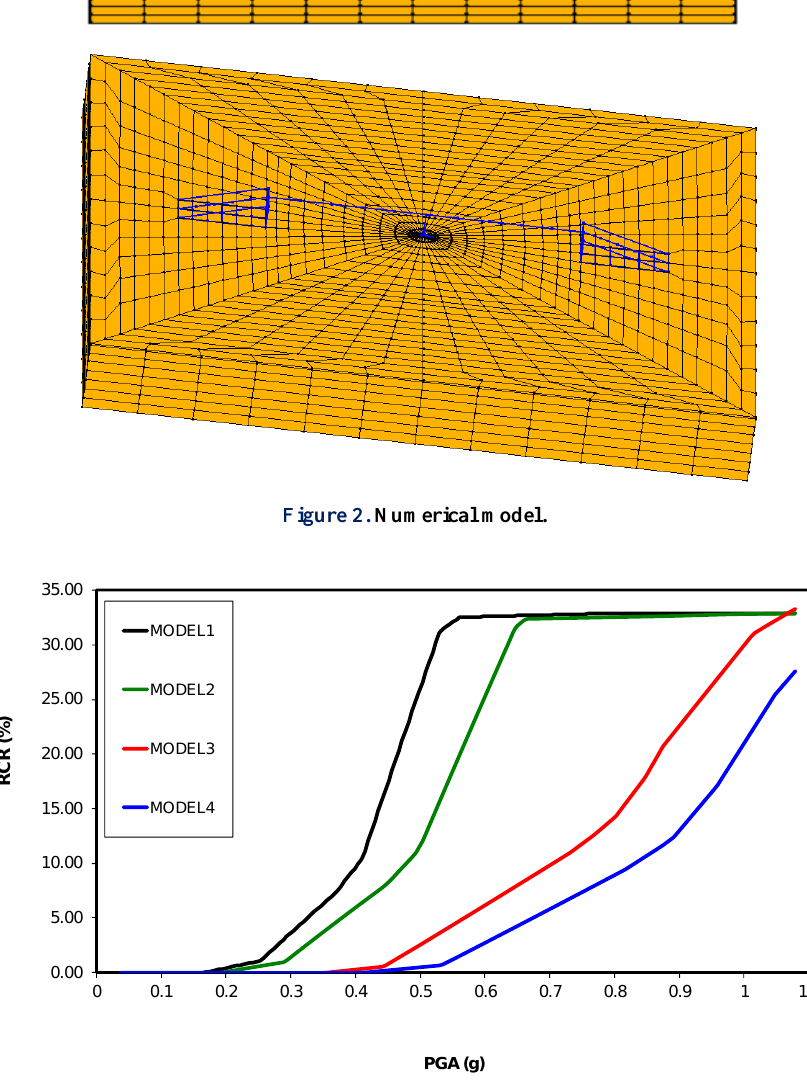
Figure 3. Total repair cost ratio (RCR) calculated by the PBEE methodology.